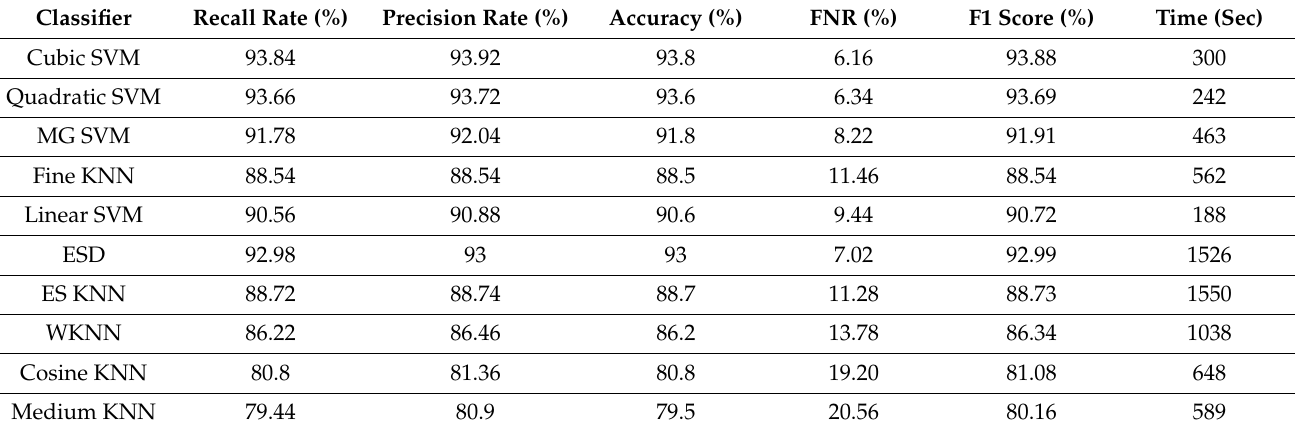
Table 3. Classification results of fine-tuned VGG16 deep model after data